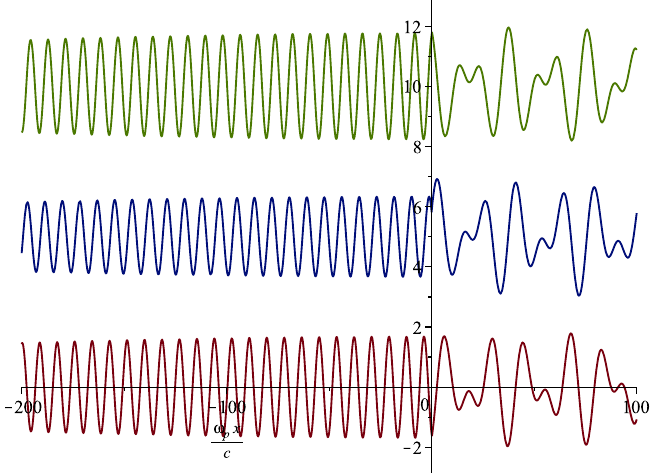
Figure 11. H field at the interface between the vacuum ( x < 0) and the metamaterial with negative index of refraction ( x > 0) from the bottom to the top for ω p t ranging from 5 to 9 in the steps of